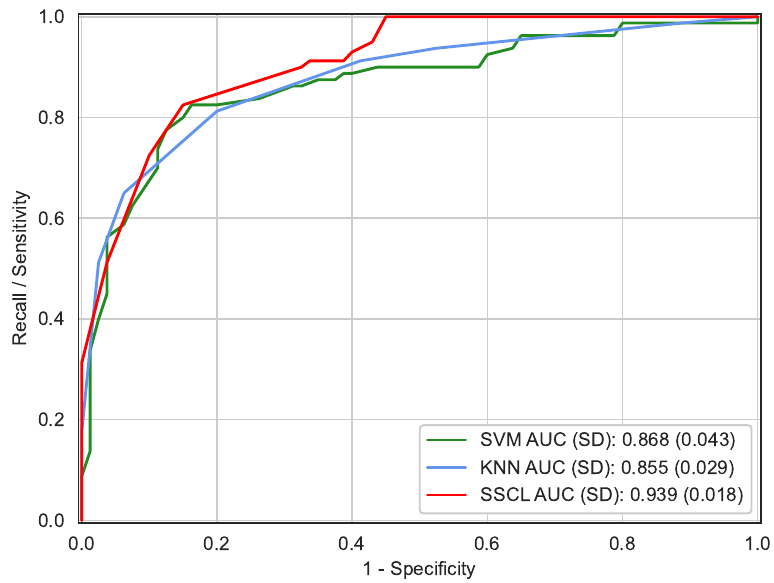
Figure 3. ROC curves generated by the SVM with radial basis functions, KNN, and SSCL methods, respectively. The AUC values estimated by the SVM, KNN, and SSCL methods were 0.868 ± 0.043, 0.855 ± 0.029, and 0.939 ± 0.018,